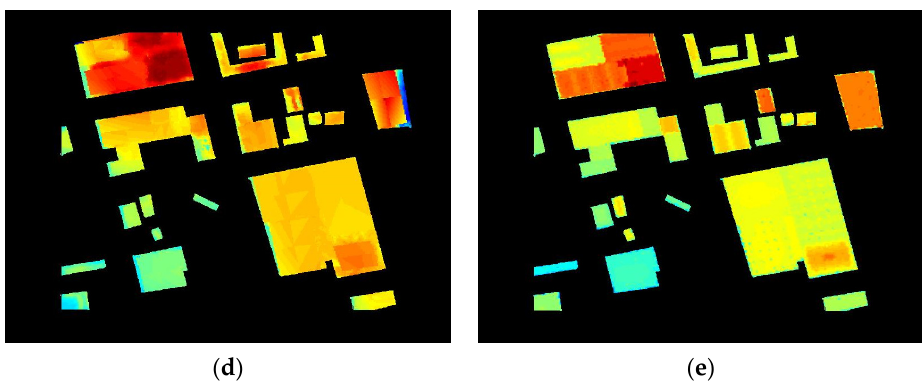
Figure 7. Comparison of DSM of buildings before and after fusion. ( a ) Original image. ( b ) DSM obtained by Method 1. ( c ) DSM obtained by Method 2. ( d ) DSM after fusion. ( e ) Truth map. Table 4. Comparison of RMSE before and after fusion.